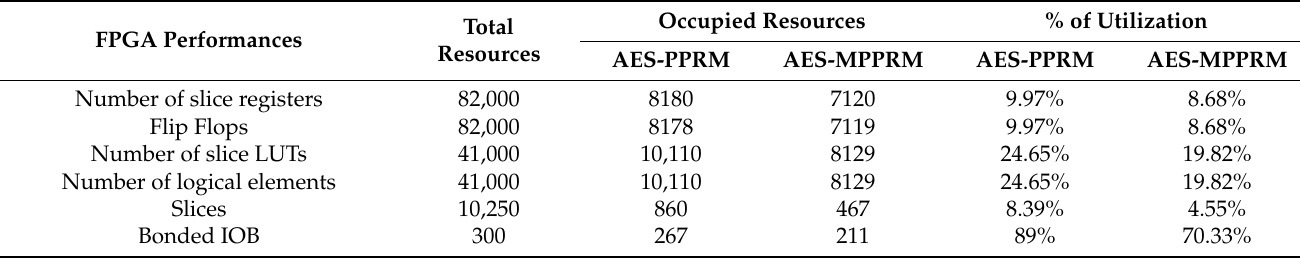
Table 3. Hardware utilization analysis of AES-MPPRM for Kintex 7 FPGA